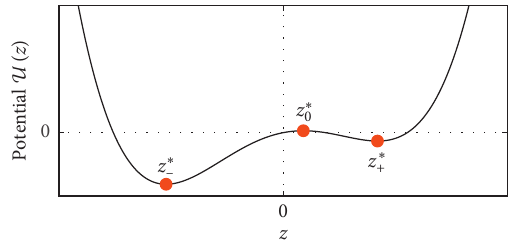
Figure 5: Potential U ( z ) . Orange dots: equilibrium positions.